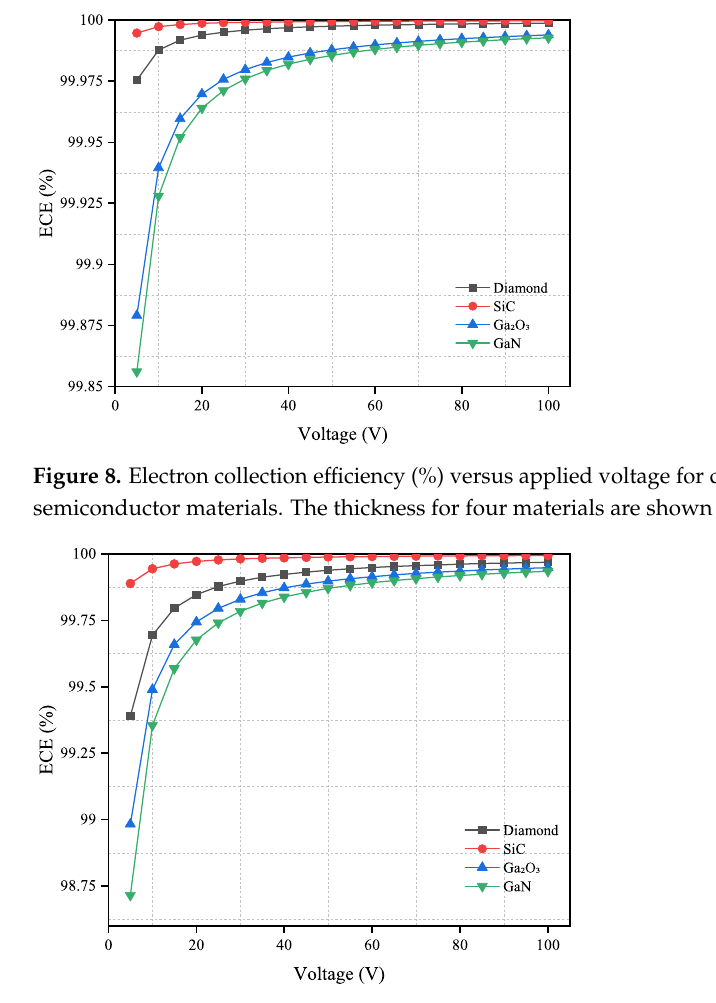
Figure 9. Electron collection efficiency (%) versus applied voltage for diamond, SiC, Ga 2 O 3 and GaN semiconductor materials. The thickness for four materials are shown in Table